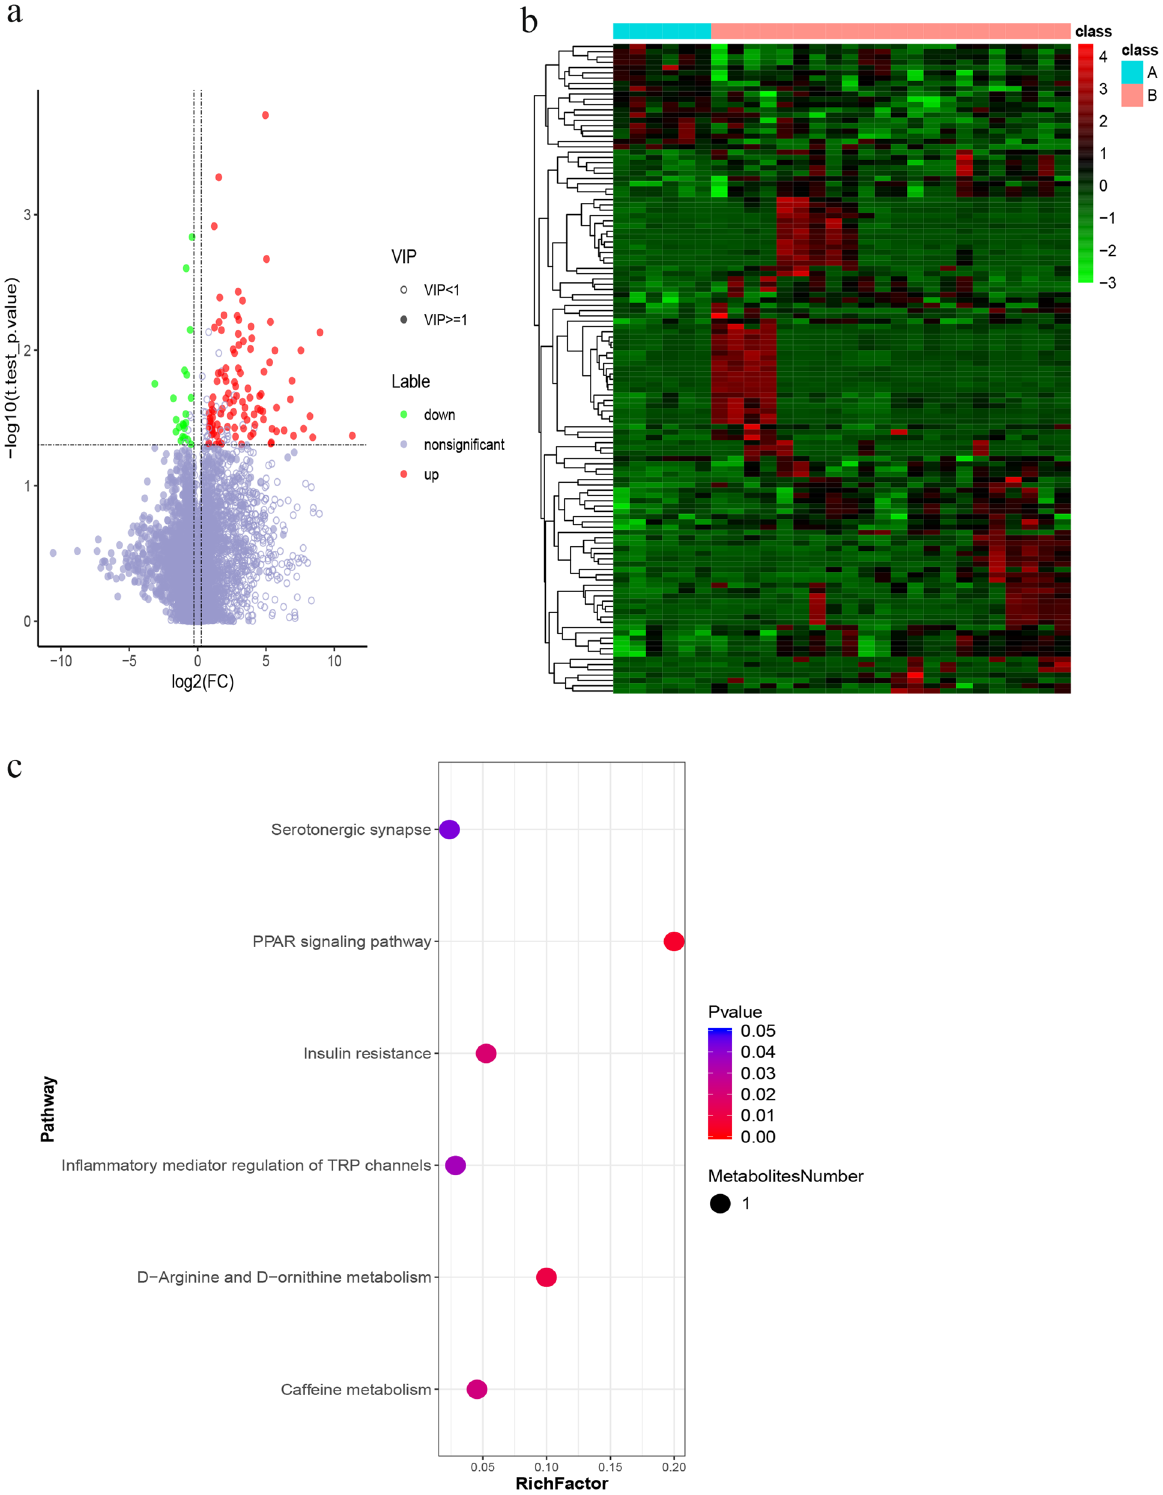
Figure 4. Positive differentially expressed metabolites were identified, clustered and enriched in Covid-19 patients with pulmonary fibrosis. ( a ) Volcano plots of positive compounds. Red dots, significantly upregulated metabolites; green dots, significantly downregulated metabolites. ( b ) Heatmap of different positive metabolites (“pheatmap” package in R software v3.5.0, https:// www.r- proje ct. org/). Each row denotes a different metabolite, and each column denotes a sample. A, Covid-19 patients without pulmonary fibrosis (n = 6). B, Covid-19 patients with pulmonary fibrosis (n = 22). ( c ) Bubble plot of KEGG enrichment of positive metabolic pathways. The size of the circle dot denotes the number of different metabolites. RichFactor is defined as the number of differential metabolites annotated to the pathway divided by all identified metabolites annotated to the